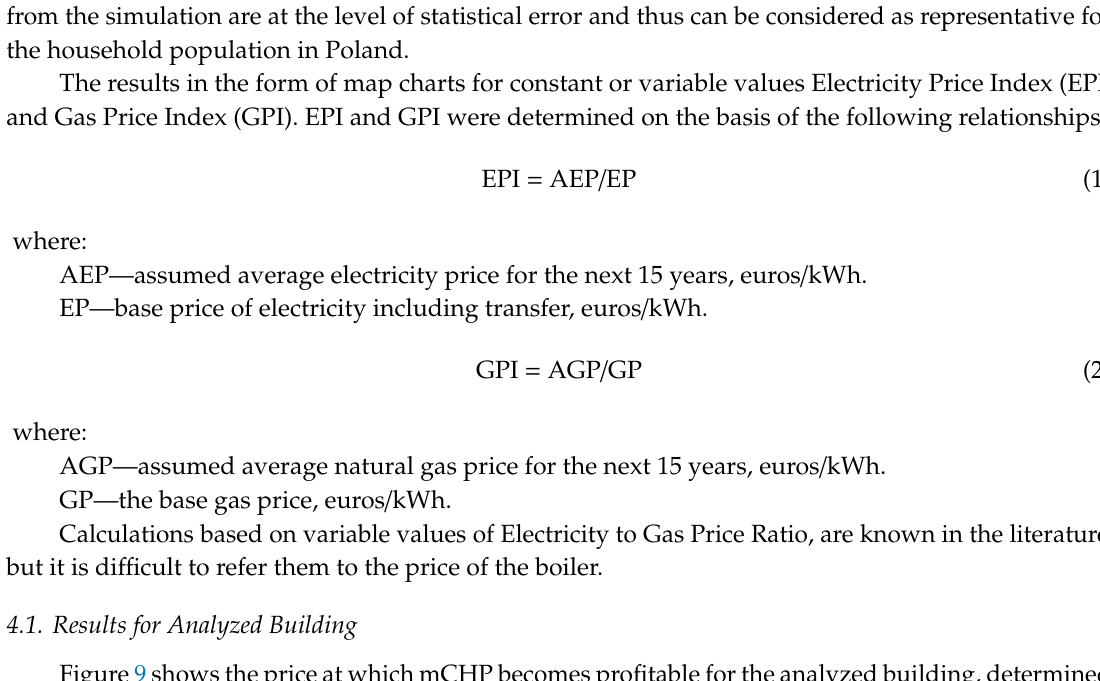
Table 5. Comparison of the value of electricity and heat demand in households in Poland. Values, TWh Parameters Calculated From Generated Data From Reference CSO [1] by the Monte Carlo method Electricity demand 29.28 Heating demand for